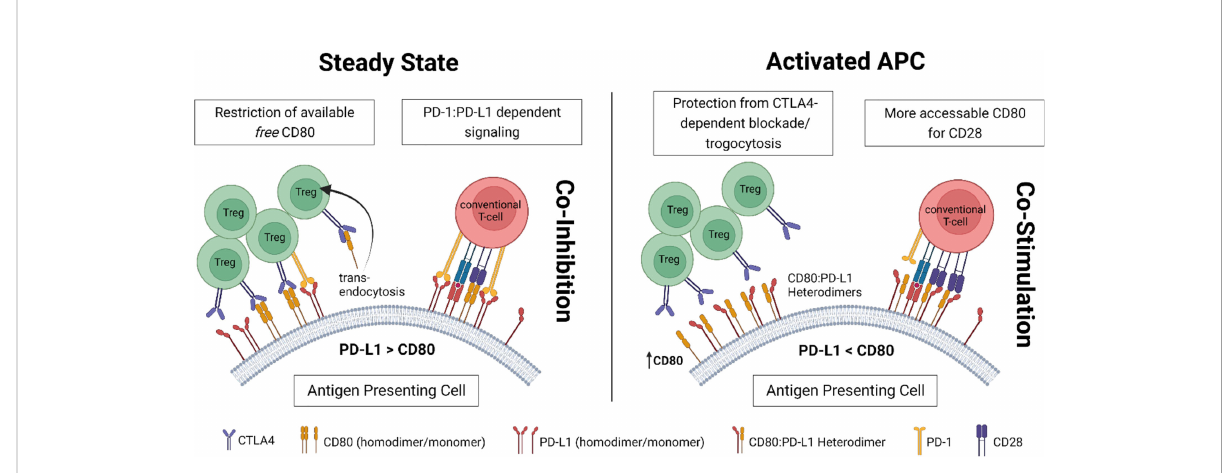
FIGURE 1 Proposed concept for the complex interconnection between Tregs and CD80:PD-L1 cis-heterodimers on antigen-presenting cells